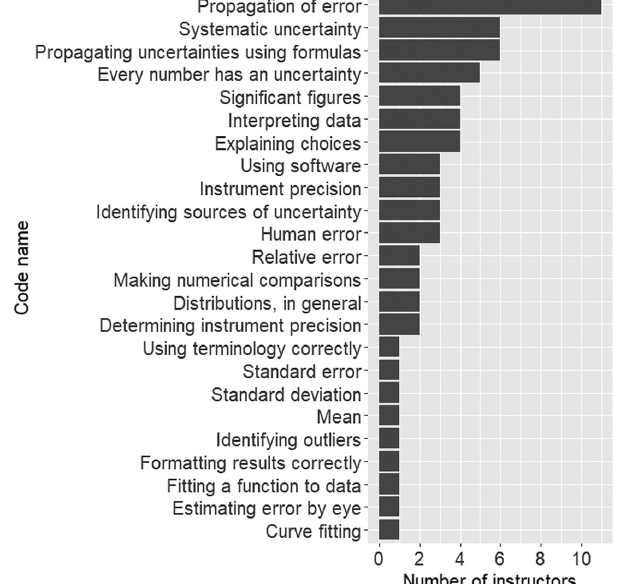
¼ 22 ) in which in- tot